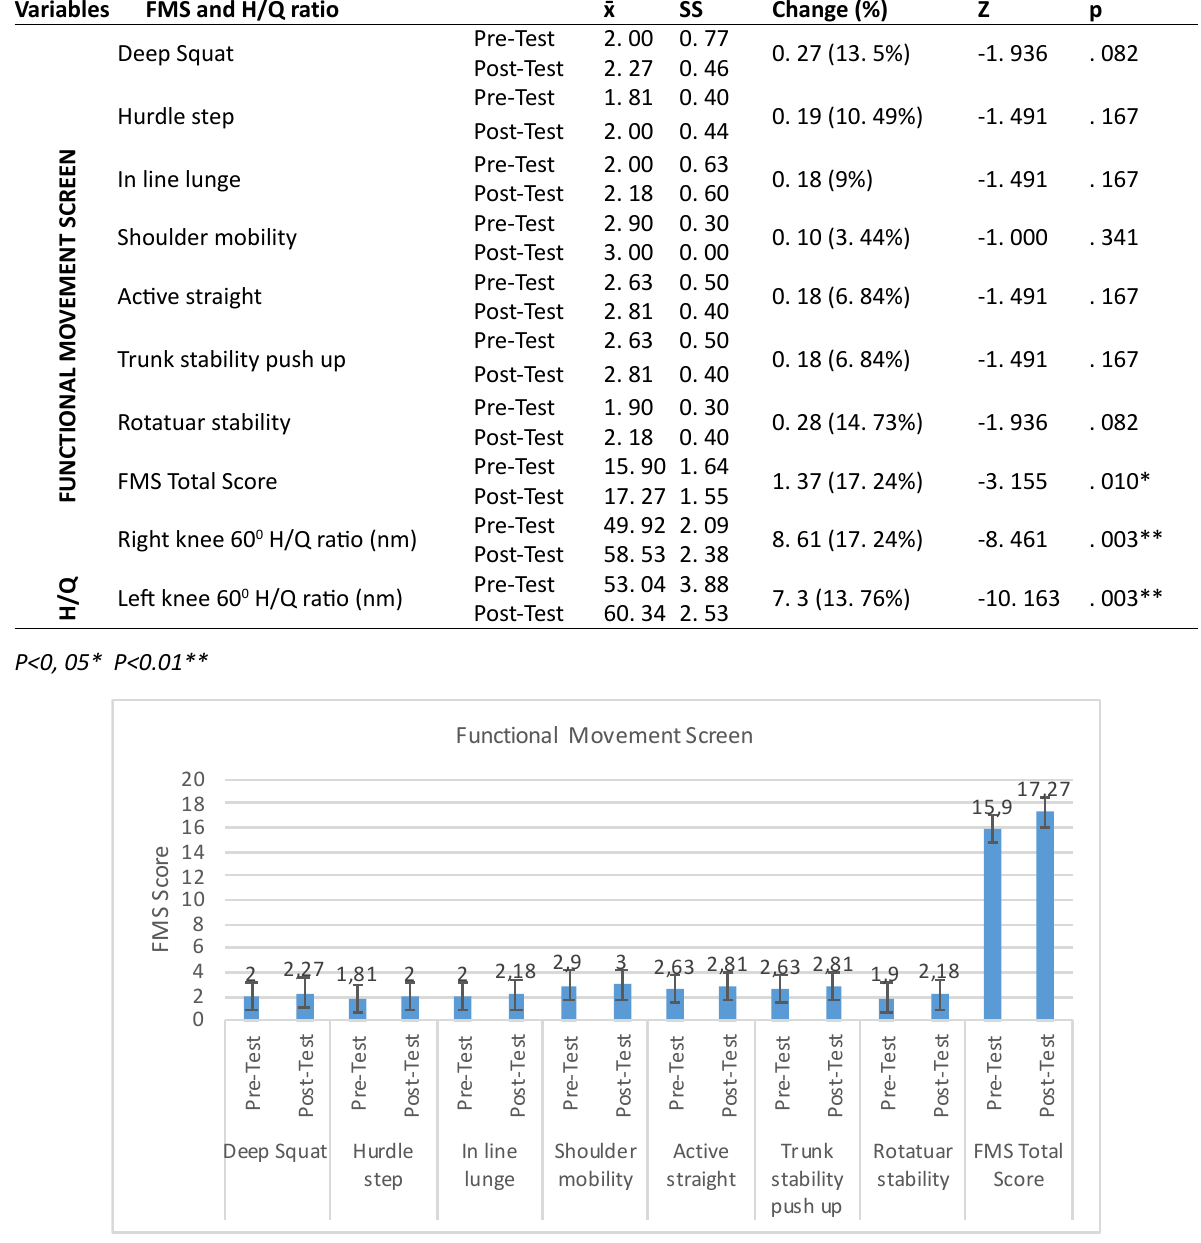
Figure 1. Football group pre-test and post-test FMS